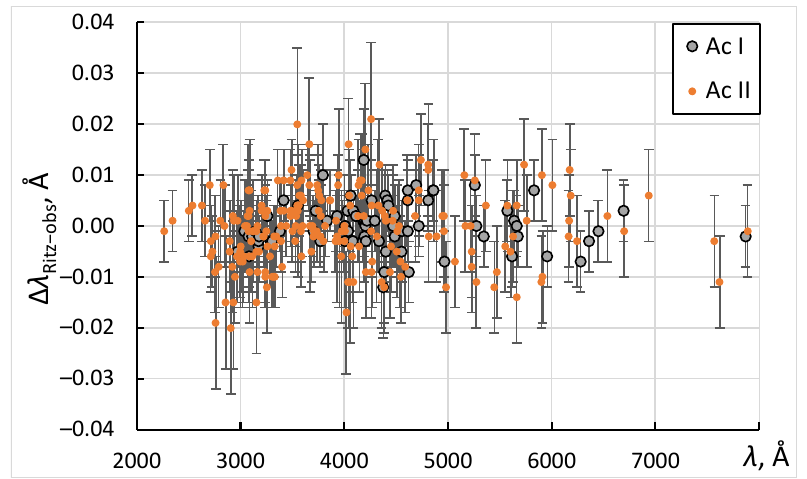
Figure 1. Observed wavelengths of Meggers et al. (1957) [9] compared with Ritz values. The error bars correspond to measurement uncertainties of Meggers et al. as assessed in the present